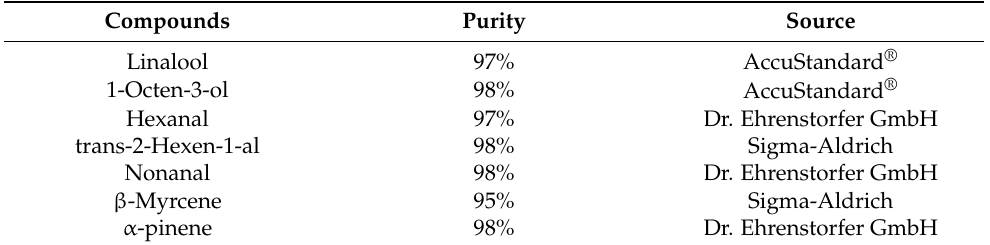
Table 1. Standard compounds used for the EAG recordings and Y-olfactometer